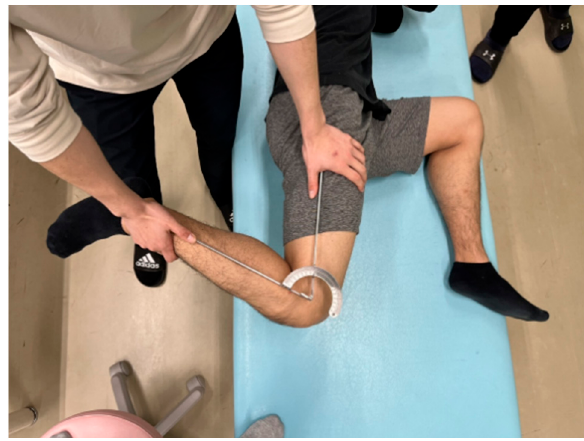
Figure 3. The knee flexion range of motion measurement.